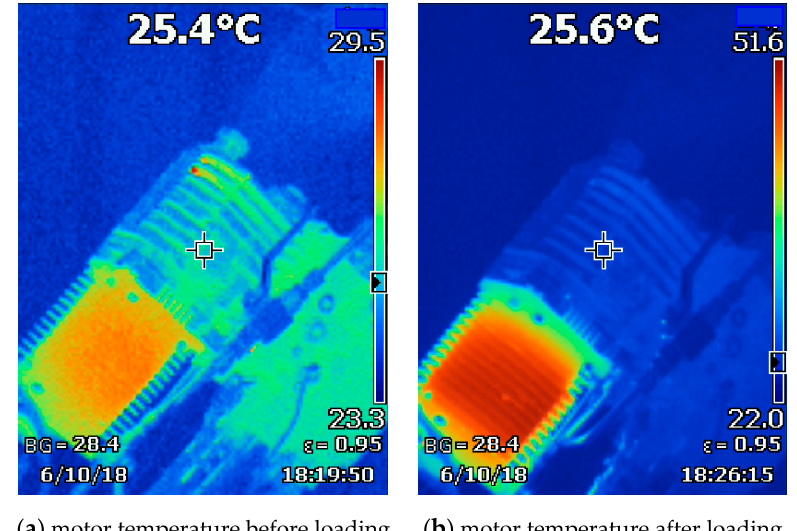
Figure 2. EHA motor surface temperature before and after loading.